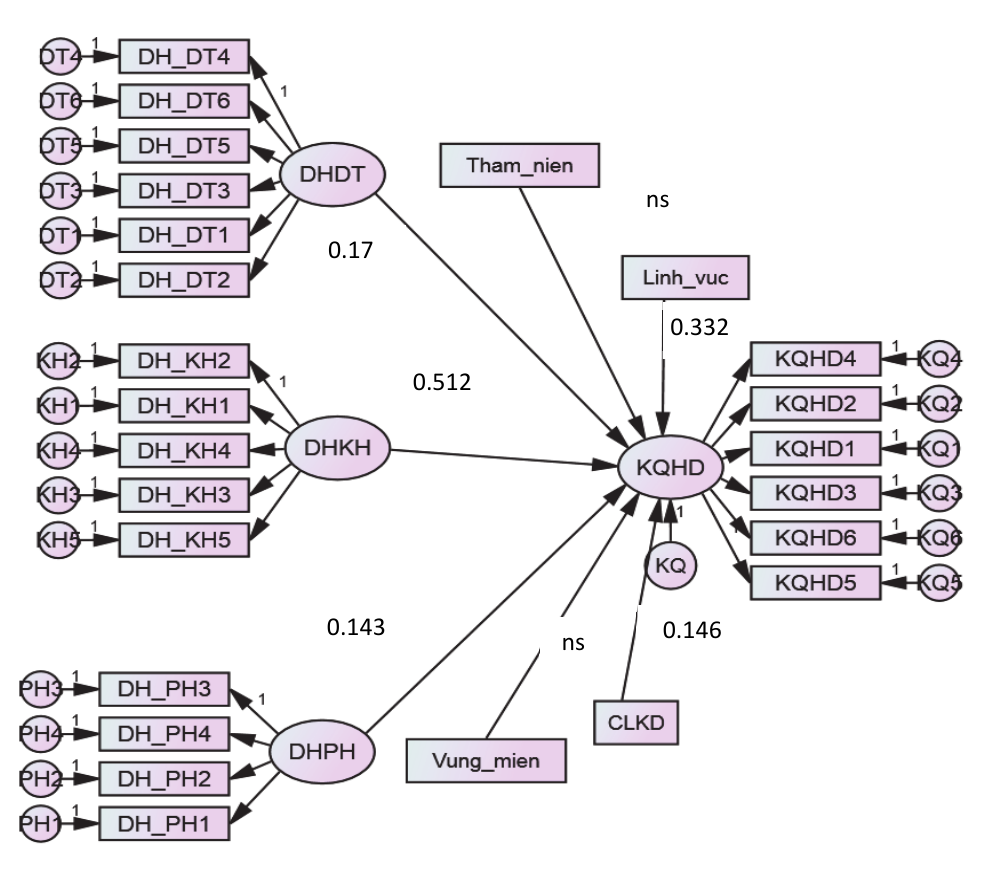
Fig. 2. Result of testing theoretical